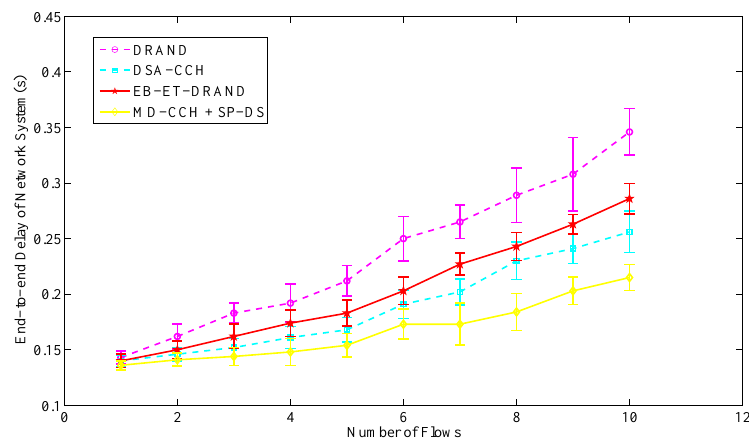
Figure 16. The average end-to-end delay of network system in different number of flows.